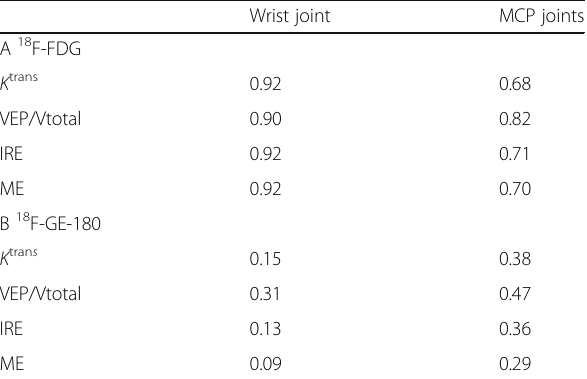
Table 6 Pearson correlation coefficients for correlations between DCE-MRI parameters and SUV max for 18 F-FDG (A) and 18 F-GE-180 (B)